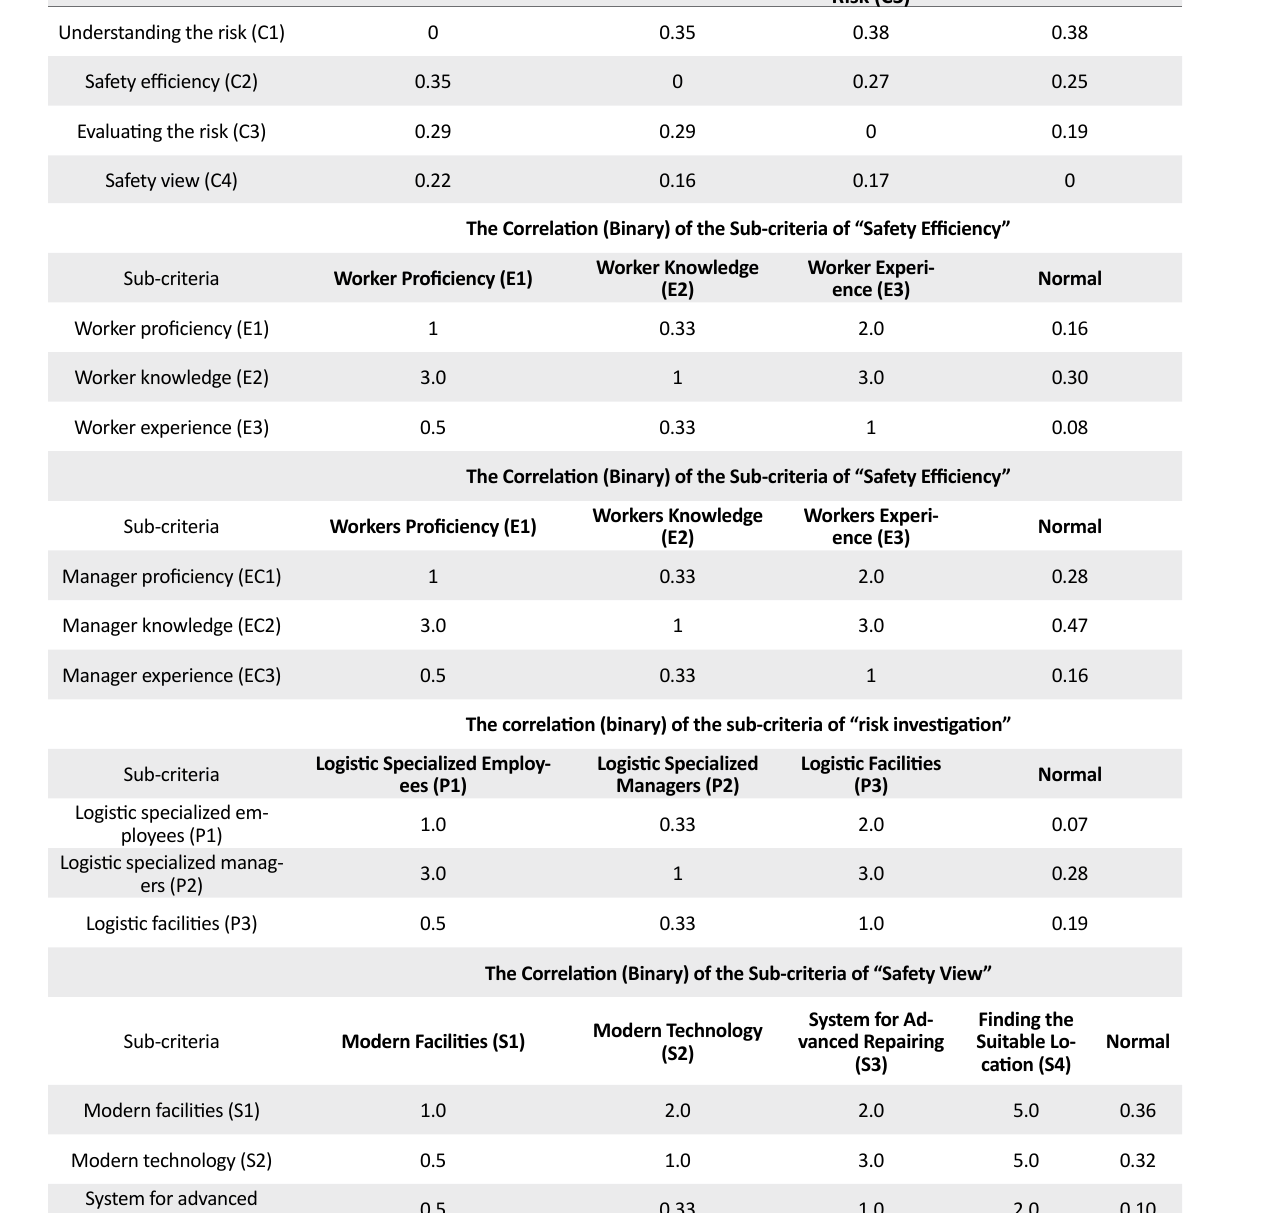
Table 2. The correlation (binary) of the sub-criteria of the health risk The Correlation (Binary) of the Main Criteria Using the Compatibility Criteria